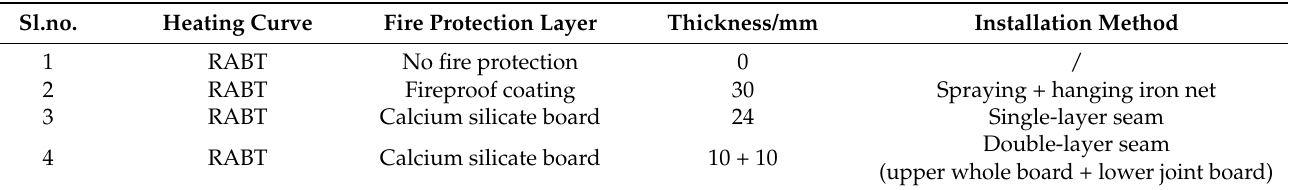
Table 1. Fireproof test conditions of tube structures.